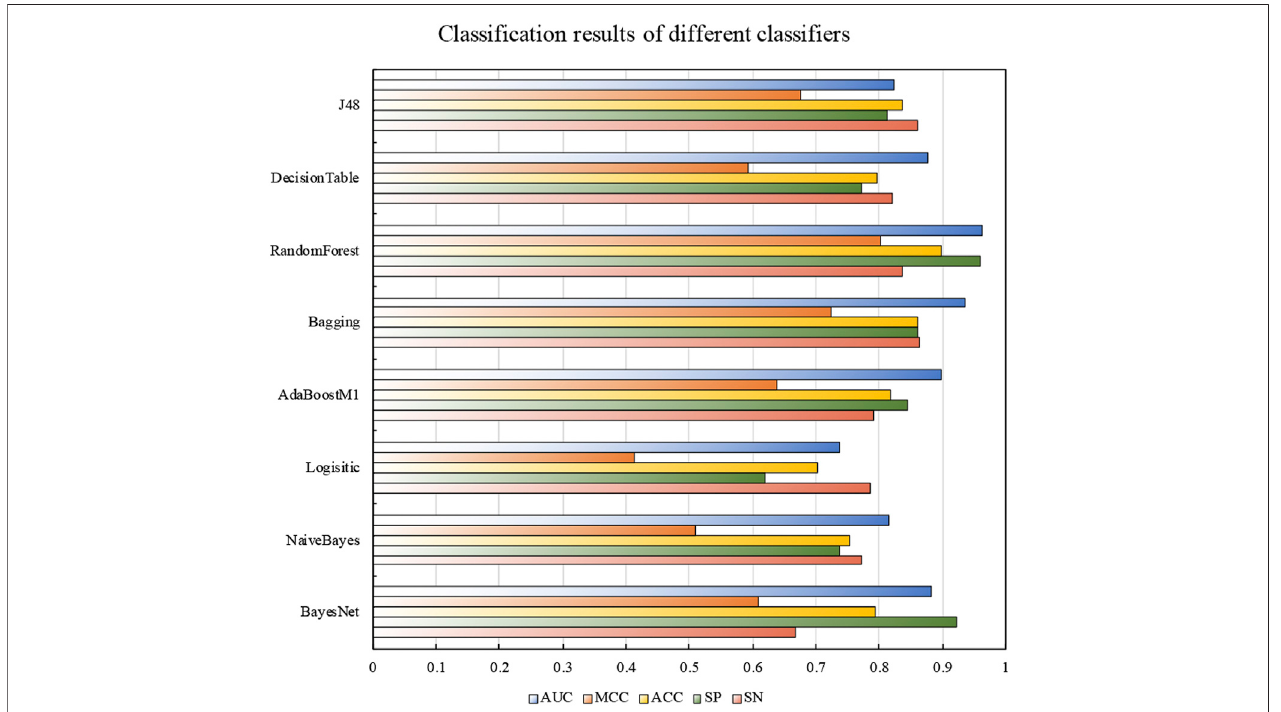
FIGURE 2 | The number of catalytic enzymes contained in different antioxidants. The catalytic enzymes of antioxidant drugs are diverse. For example, for antioxidant drugs such as Vitamin E and Carvedilol, the number of enzymes that can catalyze is as high as 9 types. Of course, some antioxidant drugs can only be catalyzed by a speci fi c enzyme, Such as Anisodamine, Silibinin, and Lipoic acid.